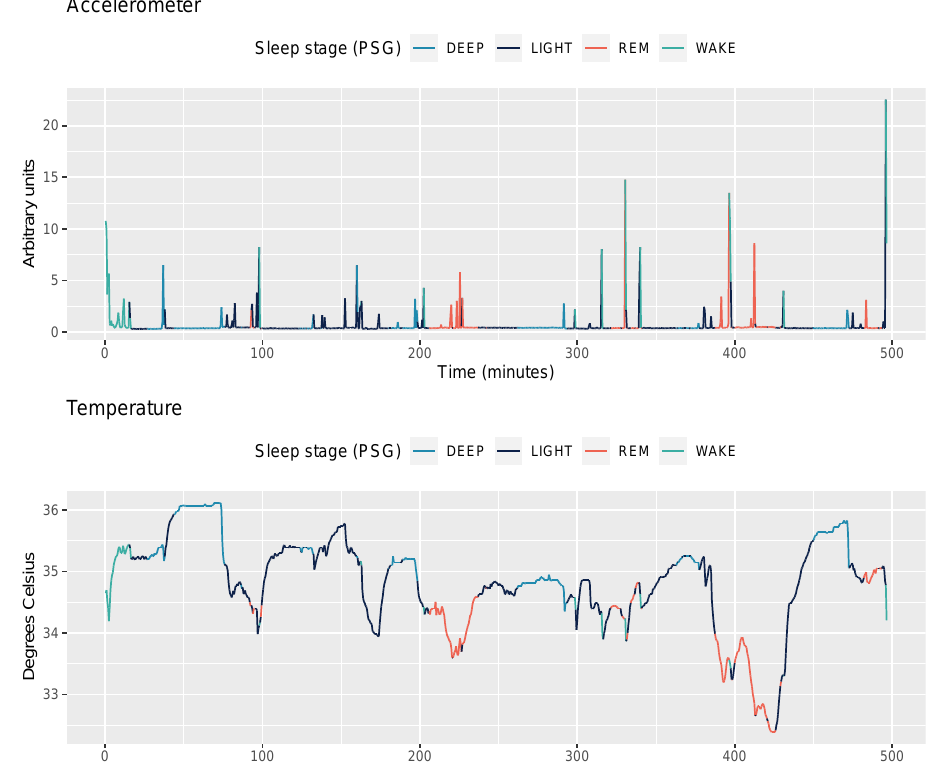
Figure 2. Accelerometer and temperature data for one participant (Dataset 1: Singapore, 15 years old) and one night. Sleep stages annotated from PSG data are